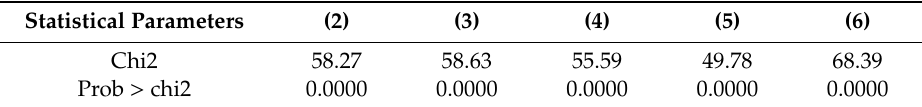
Table A3. Hausman test results.